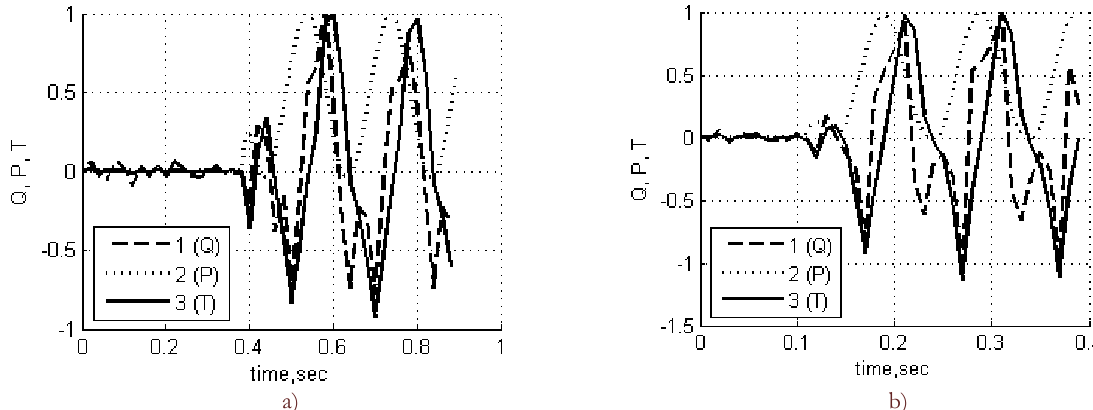
Figure 6: Heat source evolution (1), loads (2) and the temperature increment (3) at the crack tip during the loading. Loading frequency is 5 Hz (a), loading frequency - 10 Hz